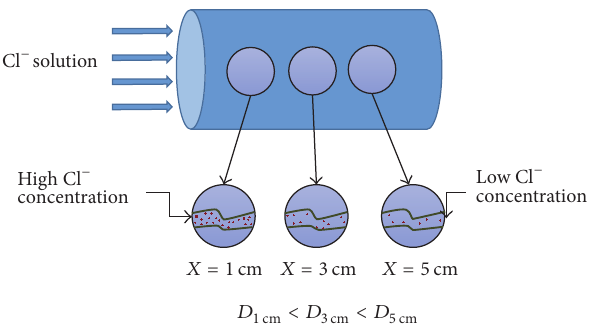
Figure 2: Effect of depth (space) on chloride diffusion coefficient